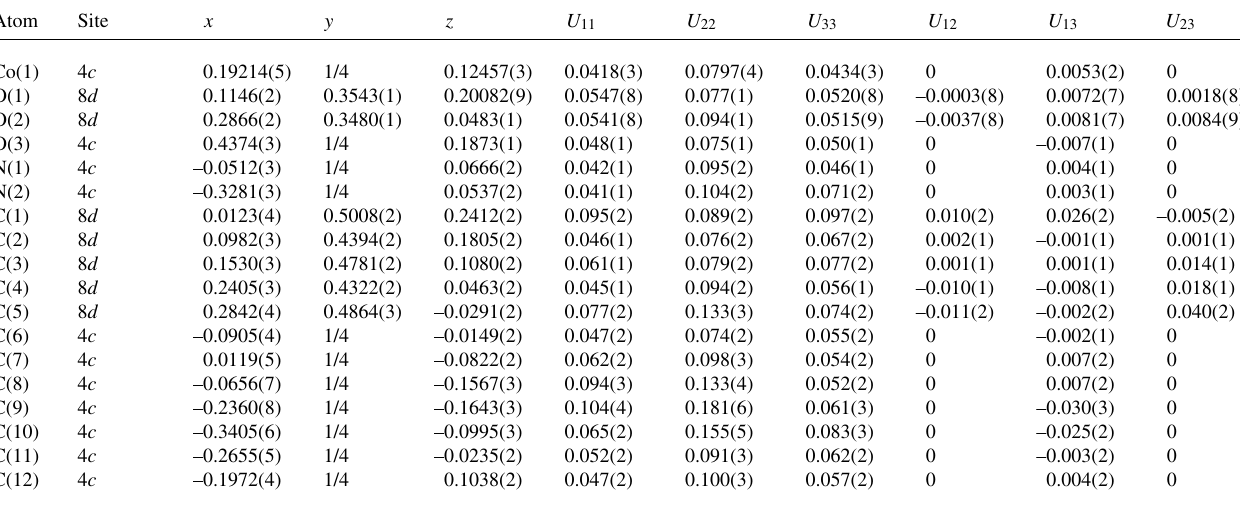
Table 3. Atomic coordinates and displacement parameters (in Å 2 )